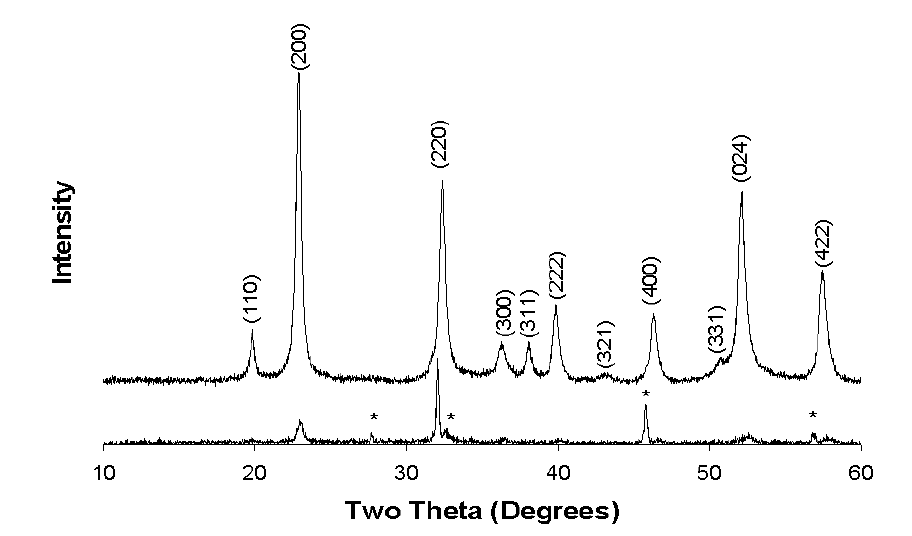
Figure 1. XRD of MnSn(OH) before washing (bottom) and after washing (top). * indicates phases corresponding to 6